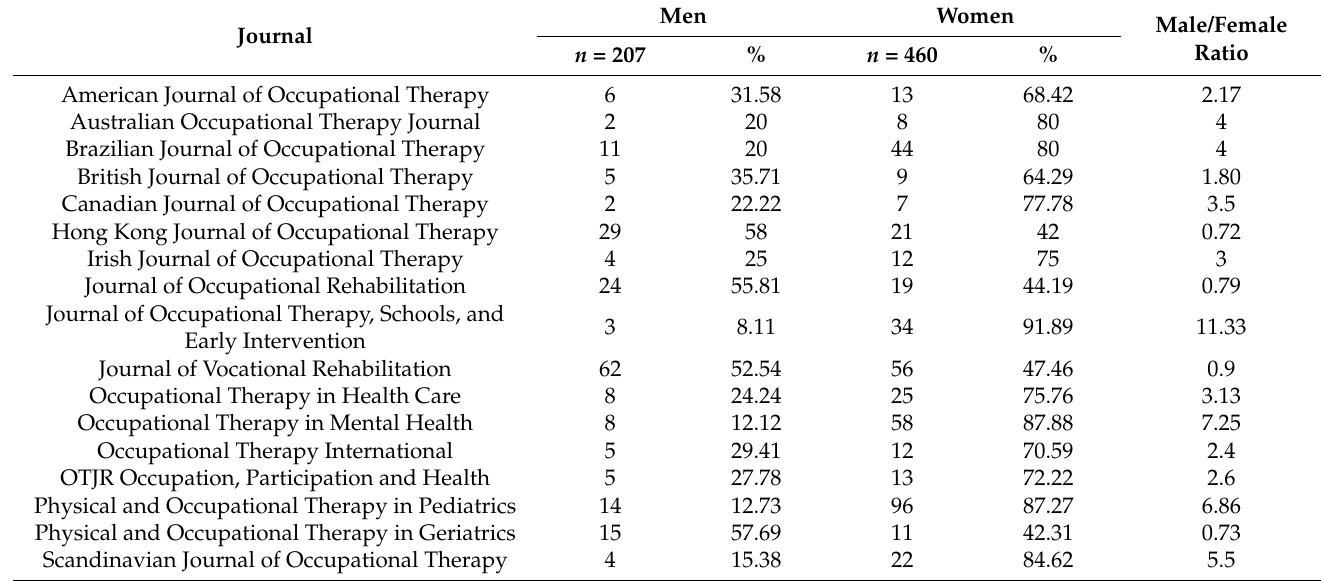
Table 4. Bivariate analysis by gender of the editorial board members.